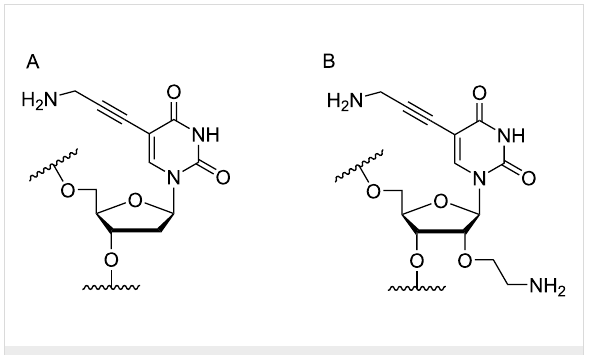
Figure 2: Structures of 5-(1-propargylamino)-2’-deoxyuridine (A) and 2’-aminoethoxy-5-propargylaminouridine